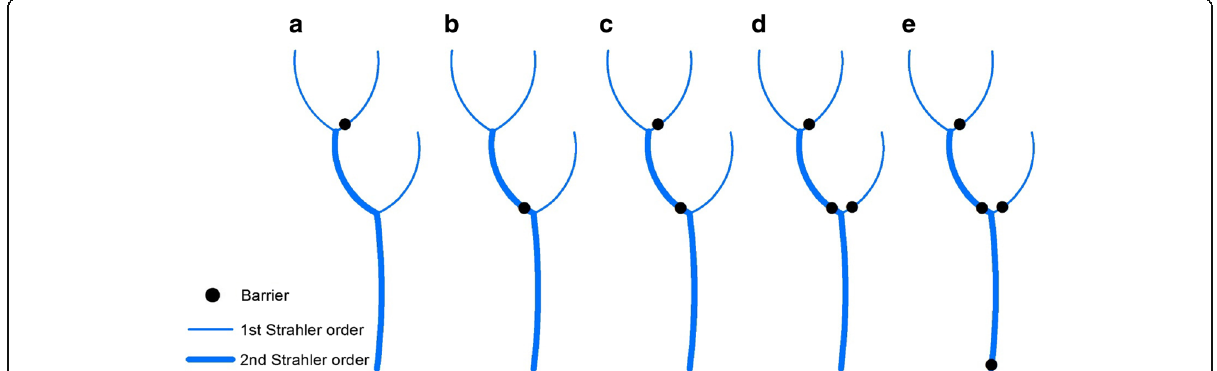
Fig. 3 Examples of different levels of fragmentation for river network shown in Fig. 1. For case a we have ∑ i IFI ( i )=1/9=0.111, then FI =1 – 1.5 − 0.111 =0.04; Likewise for cases b , c , d and e and we have respectively FI =0.16, FI =0.20, FI =0.24, FI